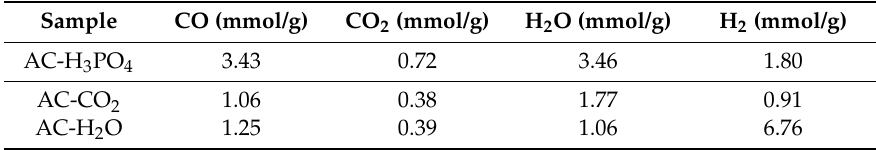
Figure 4. Desorption rates of: CO 2 ( a ); and CO ( b ) during temperature programmed desorption-mass spectroscopy (TPD-MS) of the different activated carbons. Table 2. The cumulated amount of the emitted CO, CO 2 , H 2 and H 2 O during the TPD-MS analysis for the different activated carbons.